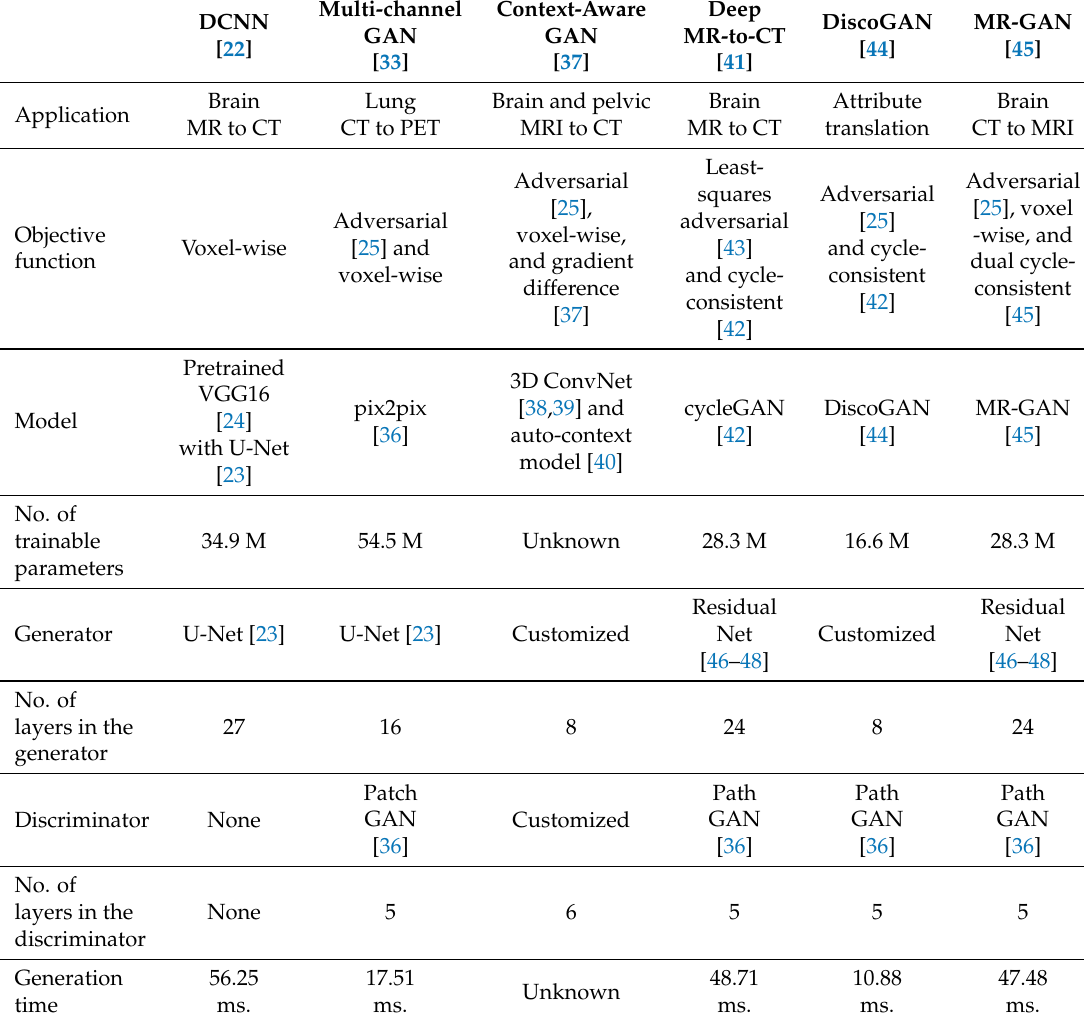
Table 2. Comparison of synthesis methods based on deep neural networks. pix2pix,